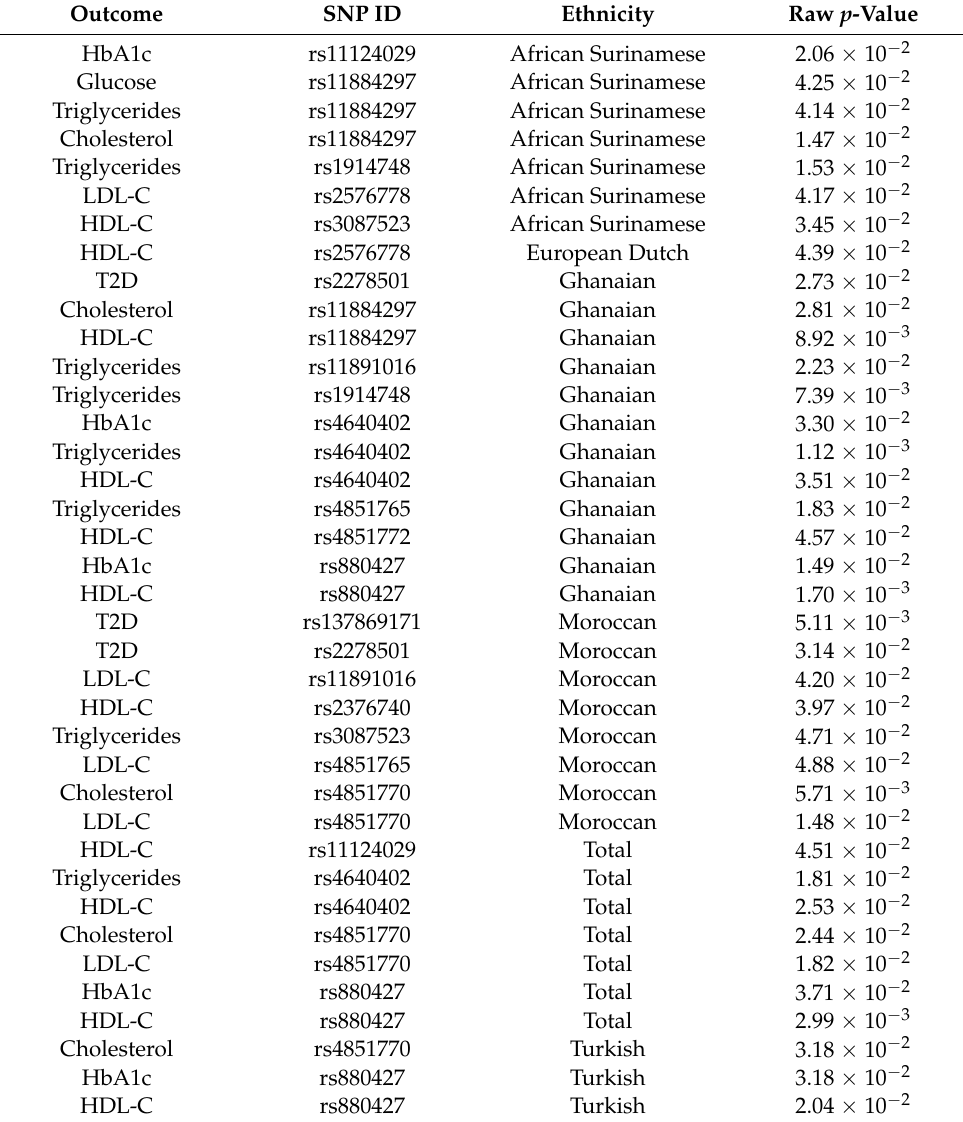
Table 3. Summary results of FHL2 SNPS associations in HELIUS